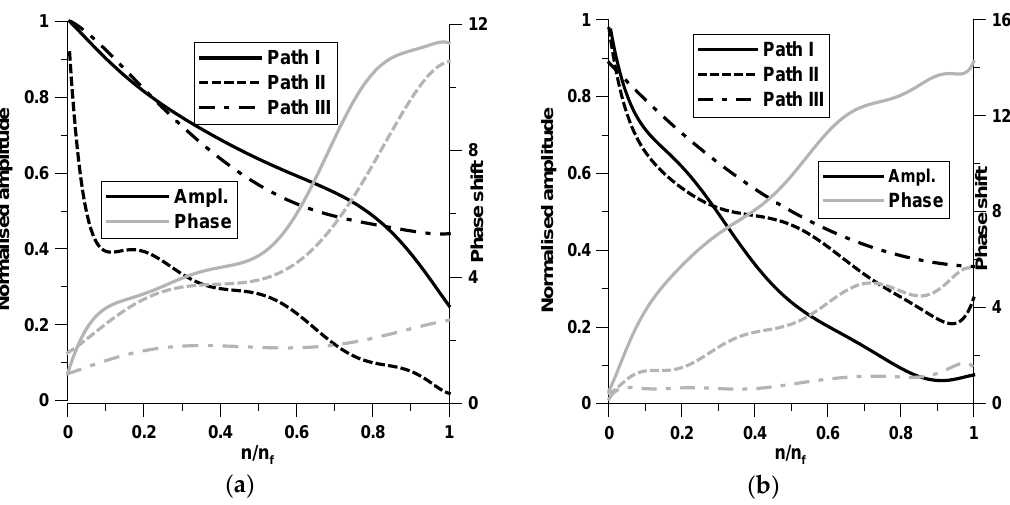
Figure 11. Comparison of the approximated amplitudes and phases: ( a ) vertical ellipse, ( b ) horizontal ellipse.